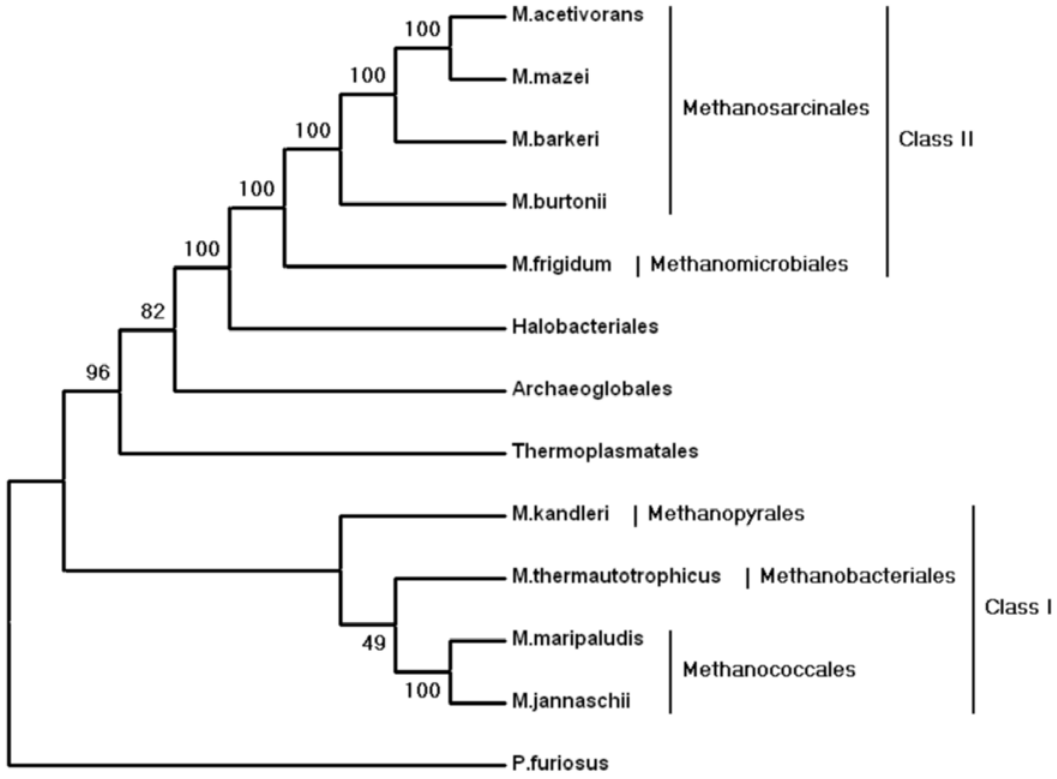
Figure 2. Phylogeny of methanogens inferred from fusion analyses of 53 ribosomal proteins. The tree was reconstructed using a maximum likelihood method. Two classes of methanogens were proposed. The tree is a reprint from Bapteste et al [3]. The intervening nonmethanogenic archaeal species are represented using the name of Order they belong to. Only bootstrap values .45% are indicated.